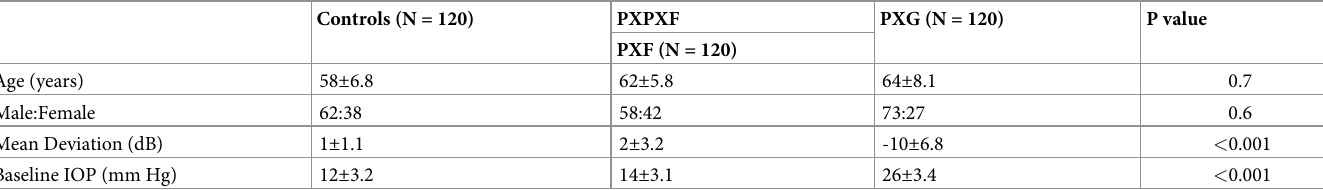
Table 1. Demographic and clinical characteristics of patients with psuedoexfoliation included in the